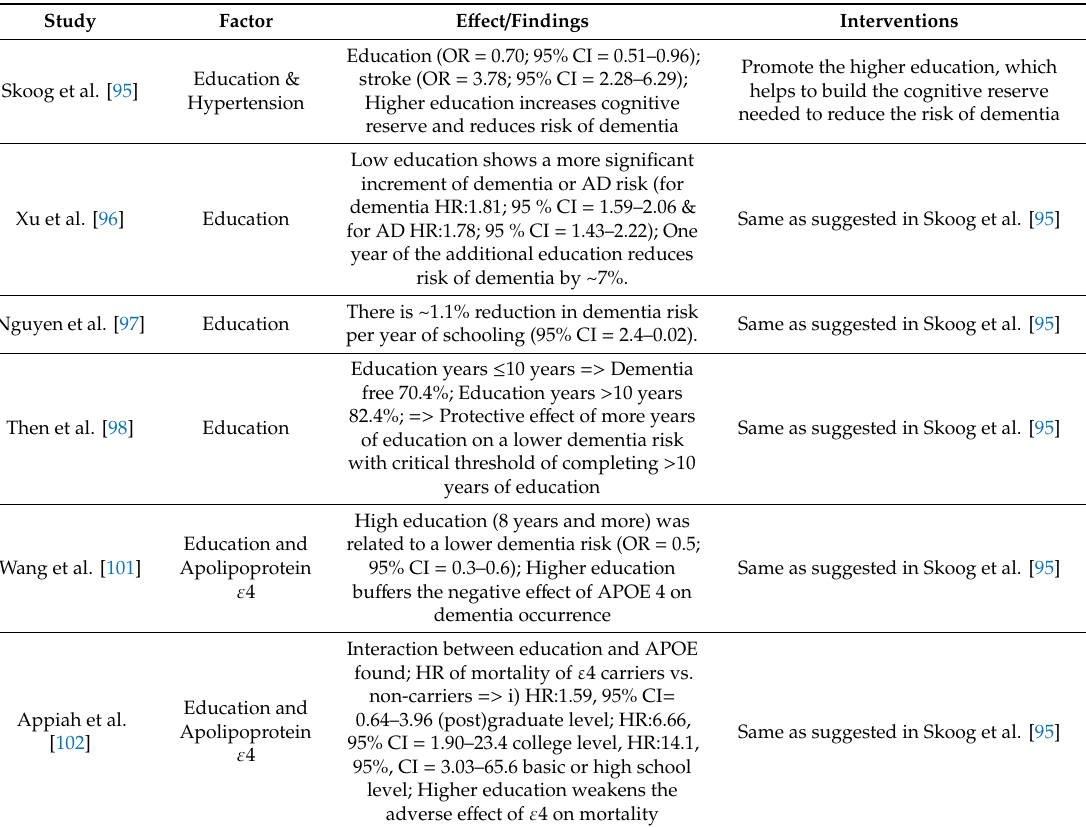
Table 4. Relationship between the education level / social engagement and the risk for development of dementia or Alzheimer’s